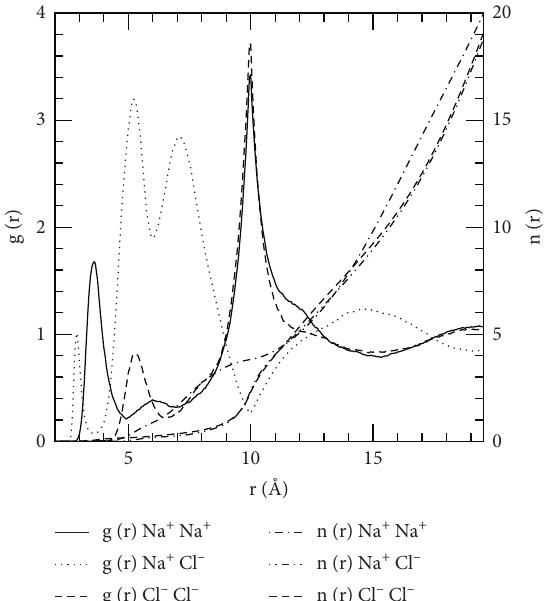
Figure 5: Radial distribution functions gNaNa(r), gNaCl(r), and gClCl(r), and the running coordination numbers, nNaNa(r), nNaCl(r), and nClCl(r) for the A6 MD system at 25 ° C as a function of r (˚A) between the ions (i) using Ewald sum with κ � 0.10 ˚A −